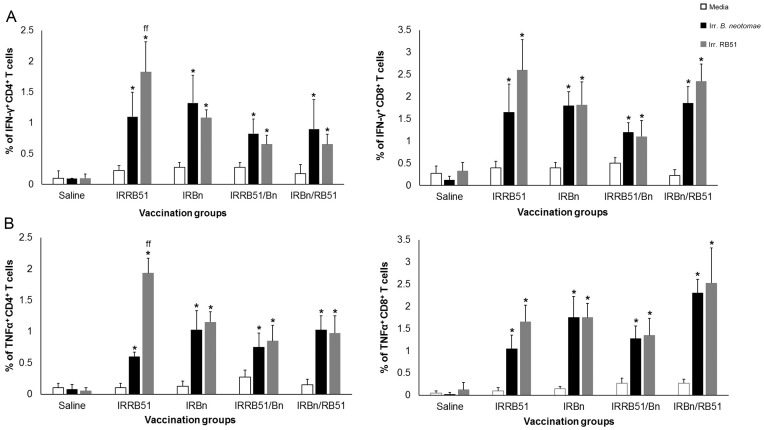
Flow cytometric analysis showing the percentage of interferon-γ secreting (A), and tumor necrosis factor-α secreting (B) CD4+ and CD8+ T cells in the spleens of BALB/c mice immunized with gamma-irradiated RB51, B. neotomae, RB51/B. neotomae and B. neotomae/RB51, or inoculated with saline following in vitro stimulation with media (unstimulated), gamma-irradiated B. neotomae and gamma-irradiated RB51.*Significantly different from the corresponding unstimulated control (P<0.05). ff Significantly different from the corresponding vaccination groups with irradiated RB51 stimulation (P<0.05).